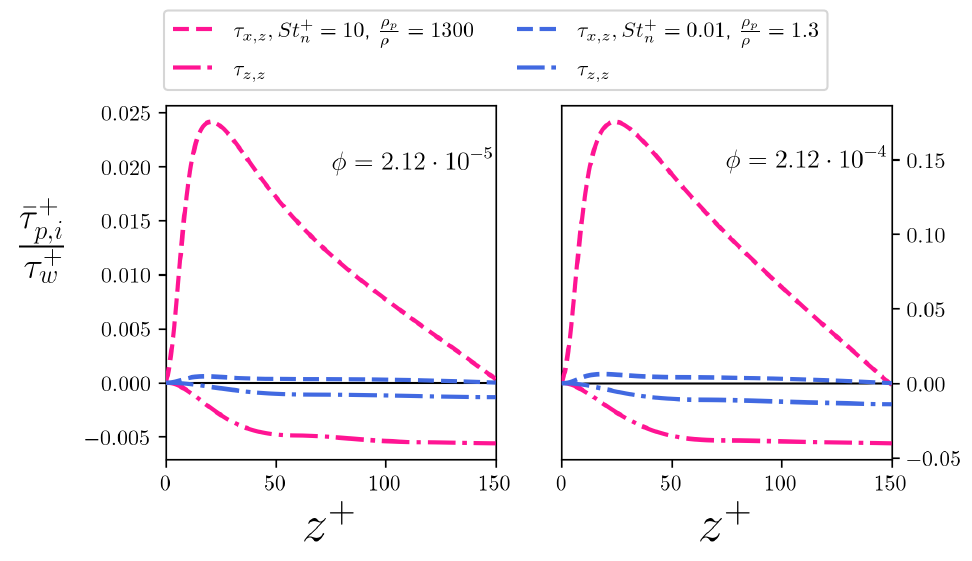
Figure 20. Particle normal stresses: ( left ) φ = 2.12 · 10 − 5 ; ( right ) φ = 2.12 · 10 − 4